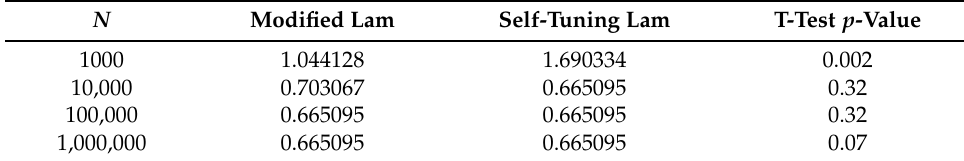
Table 11. Average solution for minimizing f 2,1 ( x ) . The minimum is f 2,1 ( x ) ≈ 0.665095.